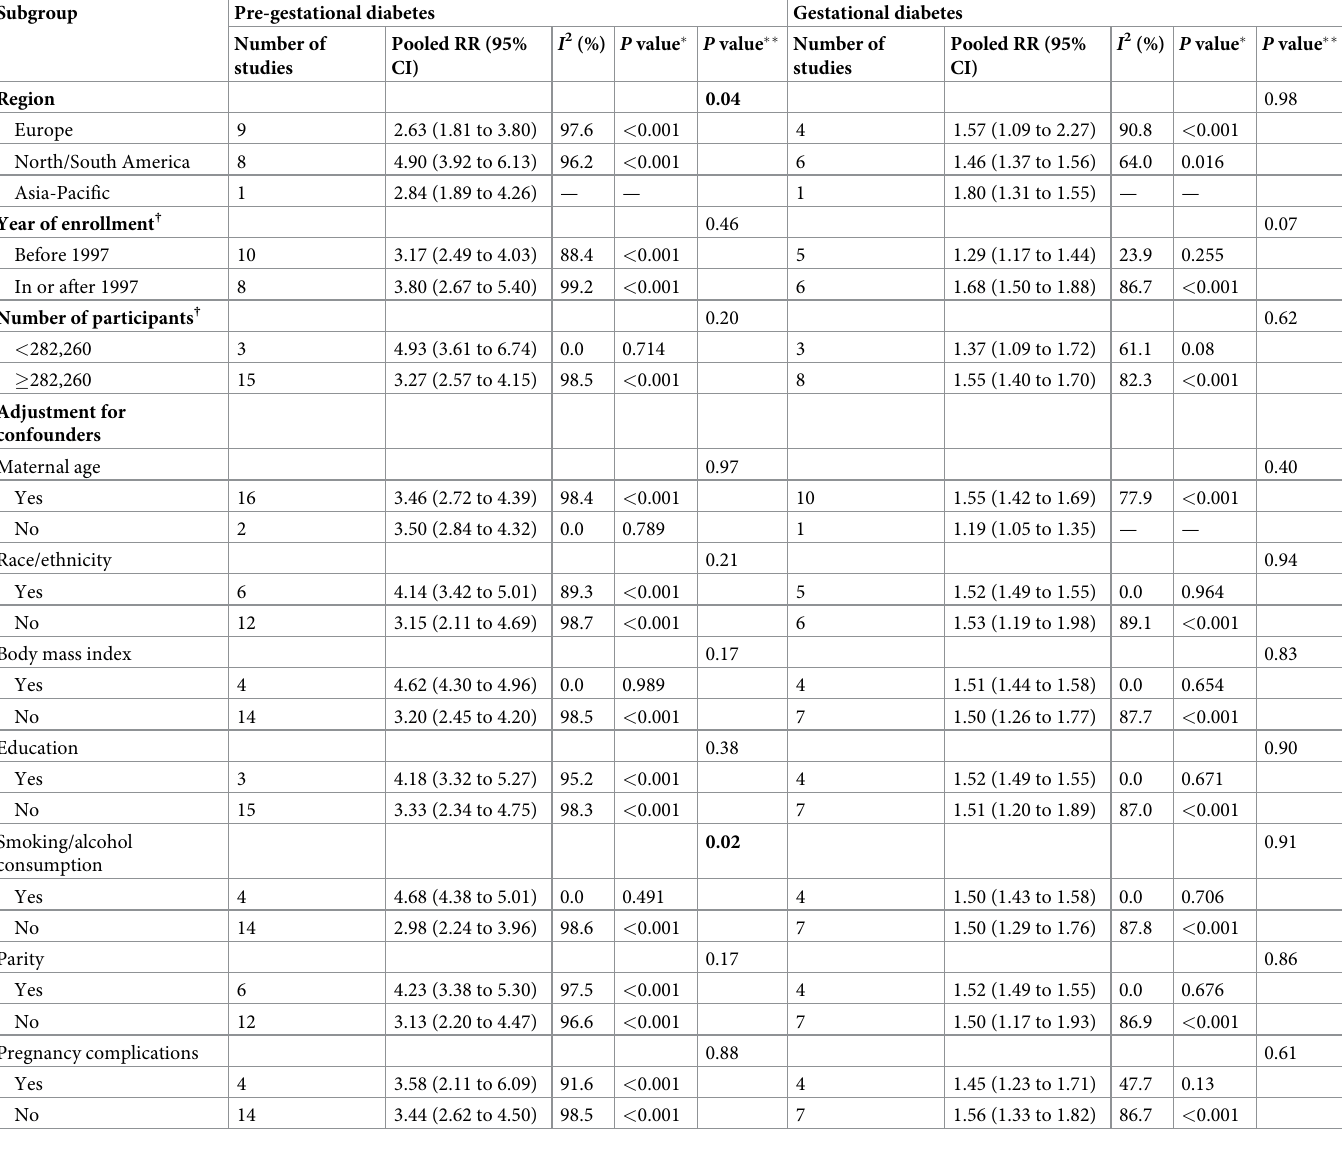
Table 5. Subgroup analysis of the association between maternal diabetes and risk of congenital heart defects in offspring: Results of meta-analyses.